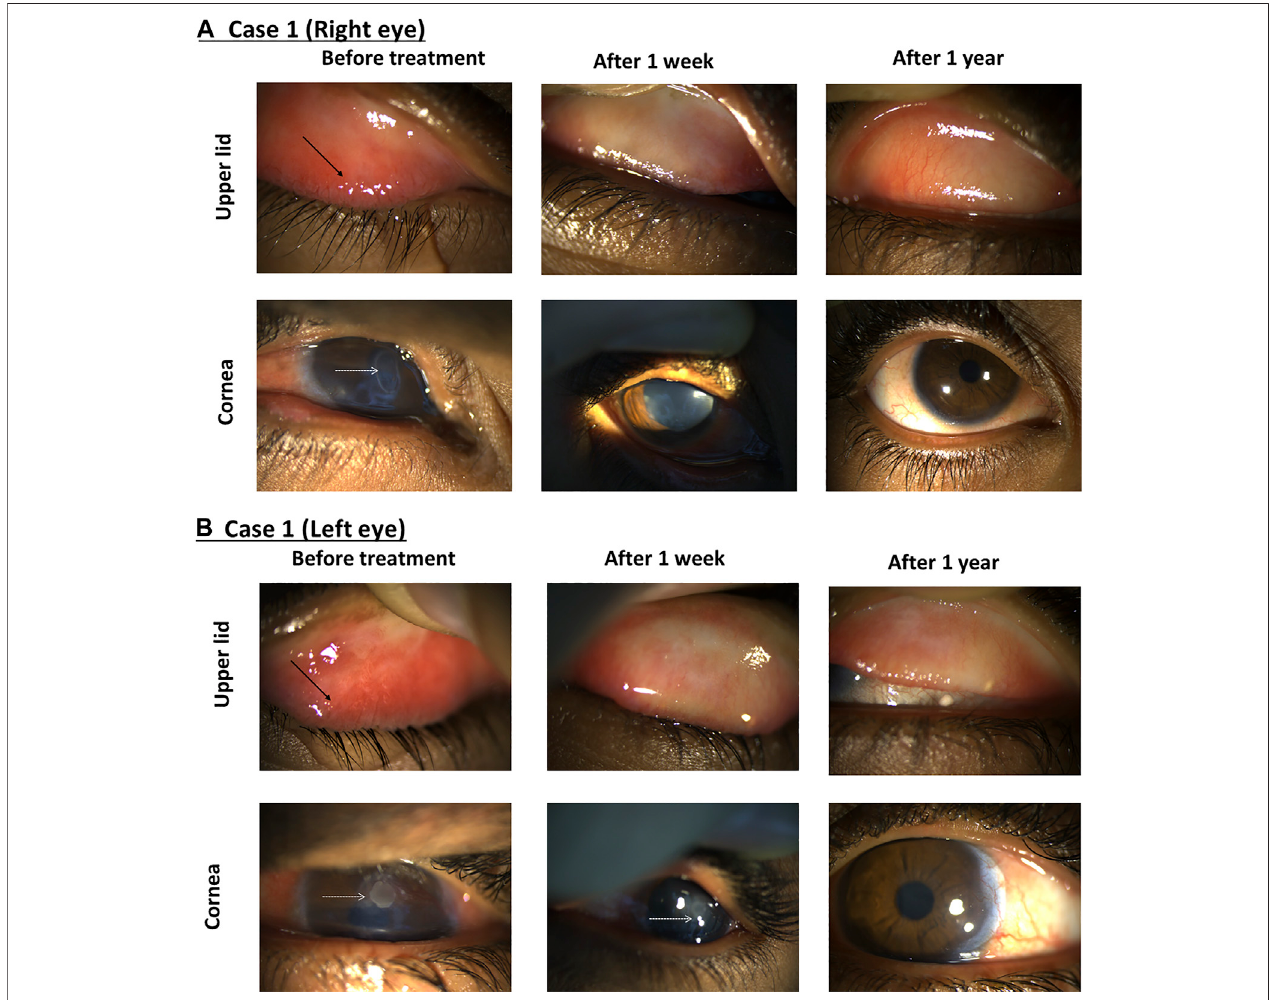
FIGURE 5 | Using tacrolimus for a case of severe VKC. The right eye (A) and left eye (B) show the upper lid (top row) and the cornea (bottom row). Images taken from the fi rst visit (left column), after 1 week (middle column) and 1 year (right column). Black arrows indicate conjunctival papillae, and white dotted arrows show shield